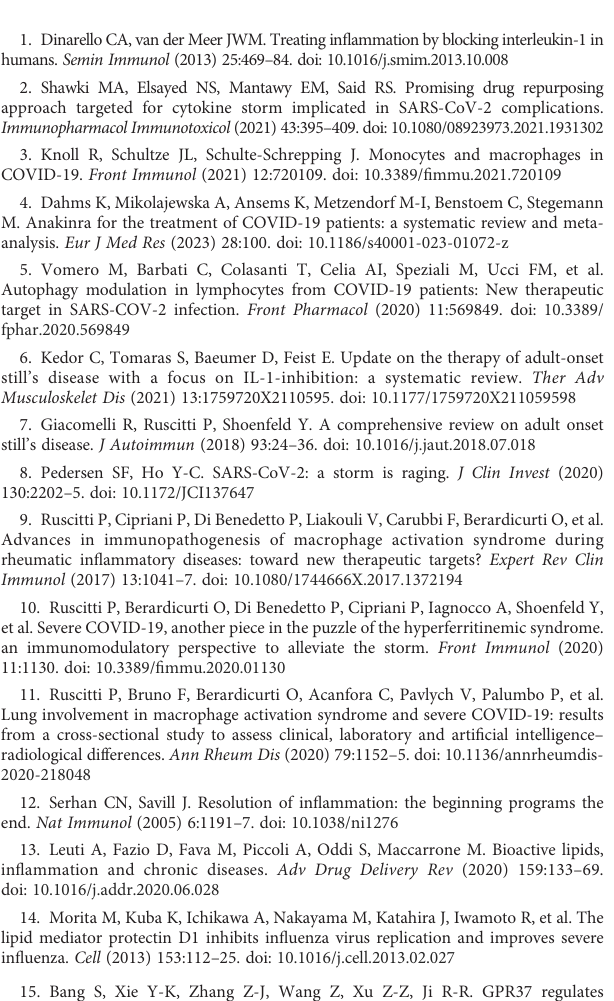
SUPPLEMENTARY FIGURE 1 (A) Gating strategy for fl ow cytometry analysis of surface markers in monocyte-derived macrophages. Population was fi rst de fi ned using forward scatter (FSC) and side scatter (SSC). Debris and apoptotic cells